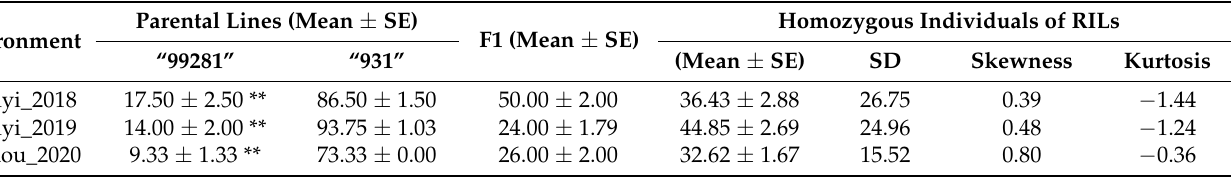
Table 1. The heat injury index of the parental lines, F 1 plants, and recombinant inbred lines (RIL) populations. Environment